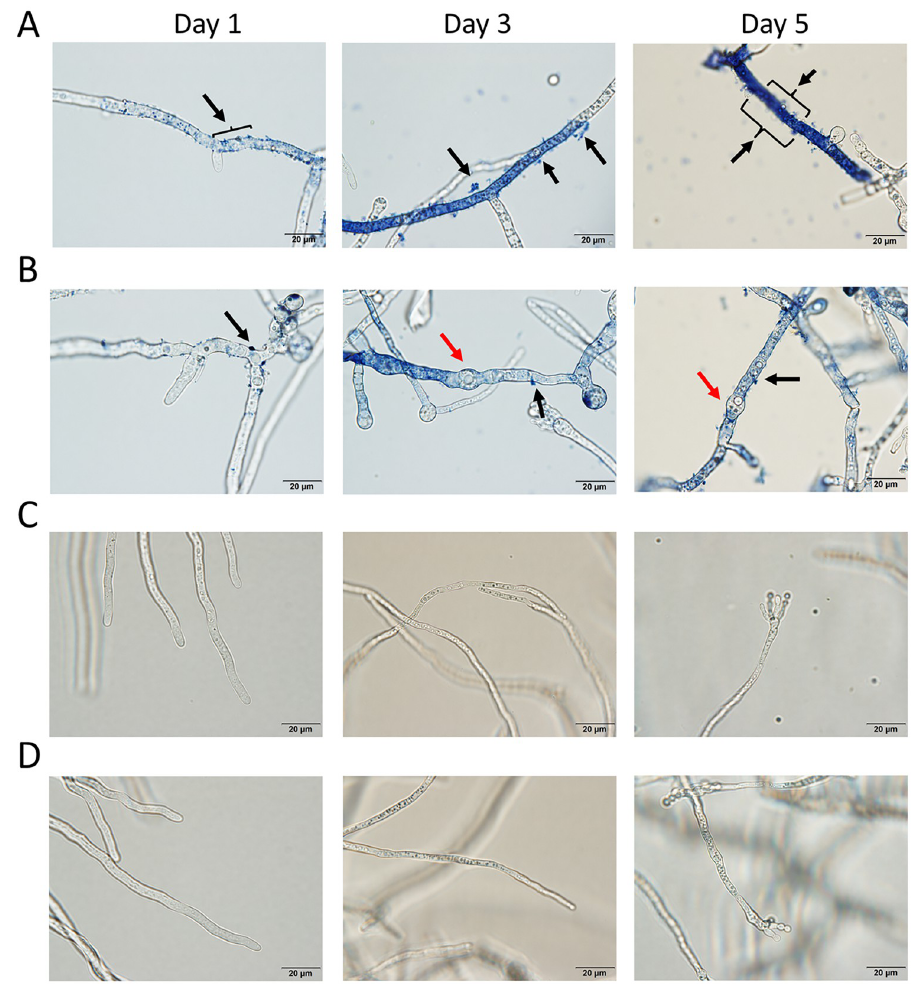
Fig 6. Image analysis of the mycelia of AoInK cultures treated with 1% Tween 80. Mycelial cultures of AoInk and recipient strains were grown at 25˚C, 200 rpm, and the samples were taken at different cultivation times for image analysis using the Olympus BX53/DP73 bright field microscope (100 × magnification). Tween 80-treated mycelia of the AoInK strain (A). Untreated mycelia of the AoInK strain (B). Black arrows indicate blue pigment granules attached to cell surface, and red arrows indicate swollen hyphae containing vacuoles. Tween 80-treated mycelial cells of the recipient culture (C). Untreated mycelial cells of the recipient culture (D). Data represent three independent